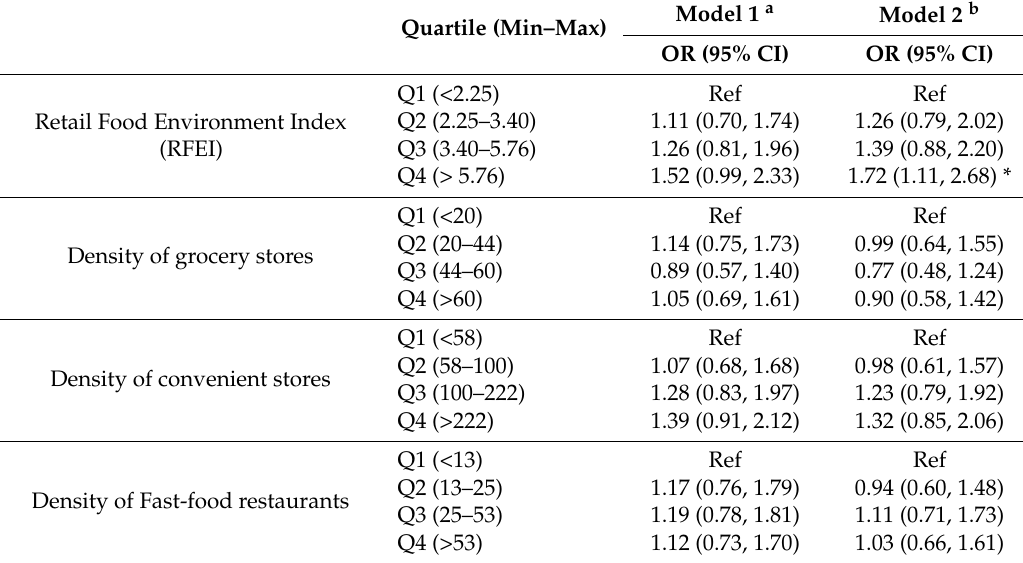
Table 4. Associations between local food environment and odds of infrequent vegetable consumption (<7 days/week) among adults in Hong Kong with binary logistic regression